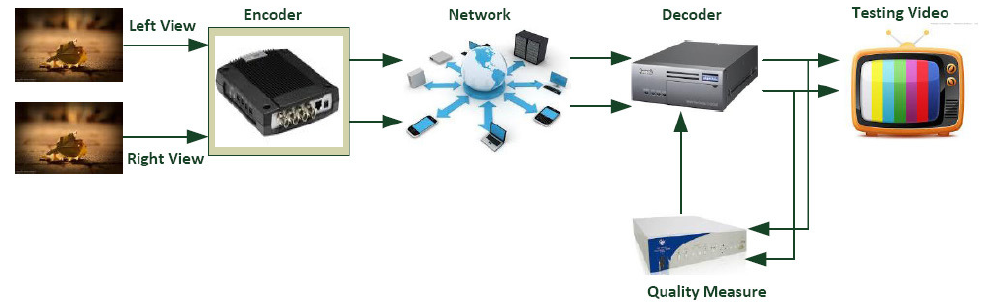
Figure 1. Typical model of no-reference video quality